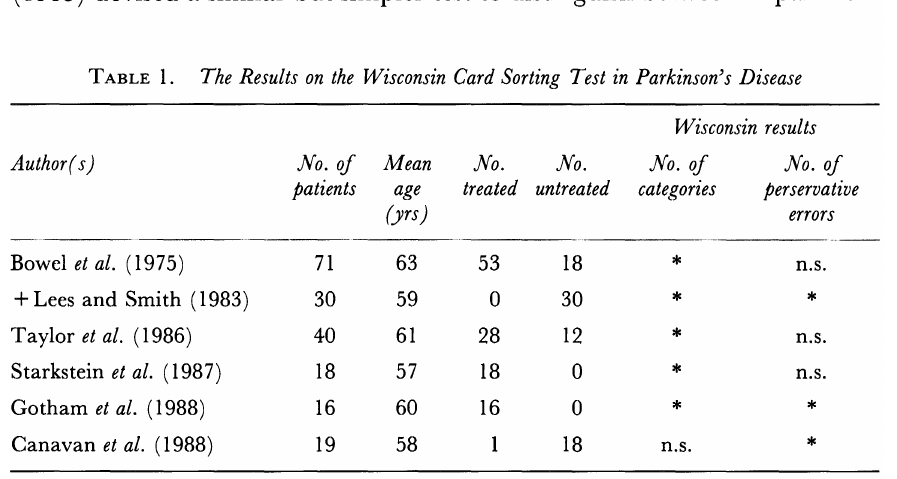
The Results on the Wisconsin Card Sorting Test in Parkinson's Disease